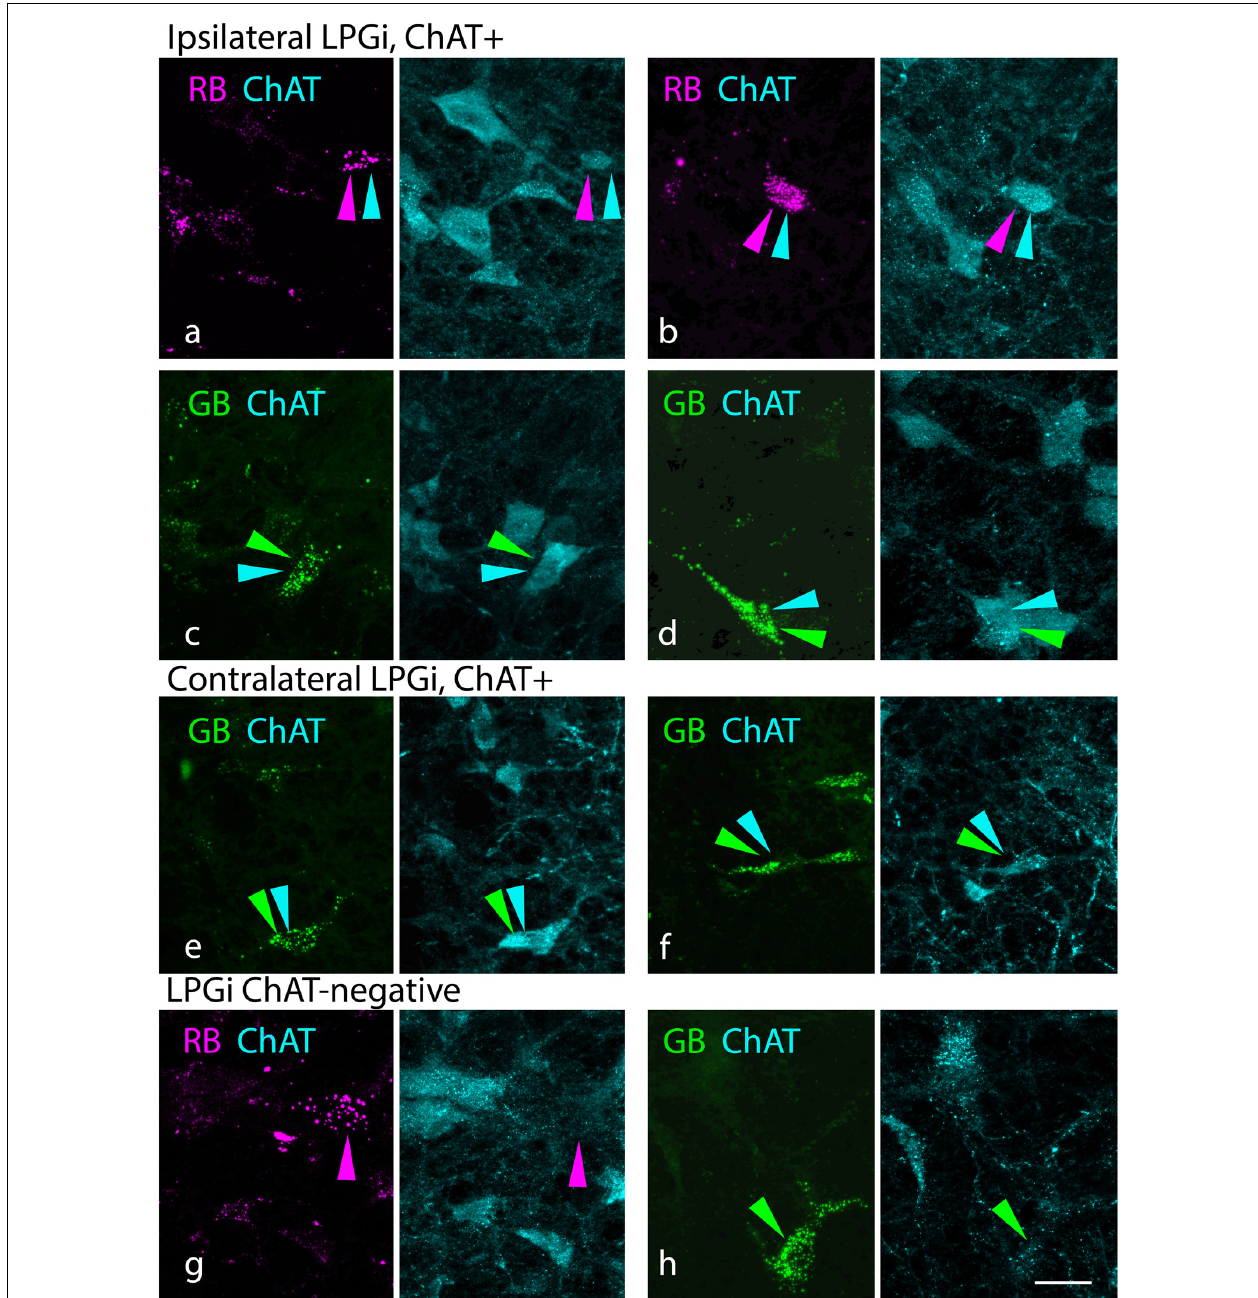
FIGURE 6 | The lateral paragigantocellular nucleus (LPGi) contains cholinergic cells that project to the SOC. Paired photographs show tracer-labeled cells (magenta or green, left panel) and ChAT immunostain (cyan, right panel), demonstrating that the tracer-labeled cells could be ChAT-immunopositive. (A–D) ChAT+ cells labeled with red RetroBeads (RB; A,B ) or green Retrobeads (GB, C,D ) in the LPGi ipsilateral to a tracer deposit. (E,F) GB-labeled ChAT+ cells in the LPGi contralateral to the tracer deposit. (G,H) Tracer-labeled ChAT-negative cells in the LPGi. Panel (B) is from deposit G18-3033 RB (lateral SOC deposit); panel (H) is from deposit G18-3030 GB (medial SOC deposit); remaining panels are from deposit G18-2012 (medial SOC deposits). Scale bar = 20 µ m.